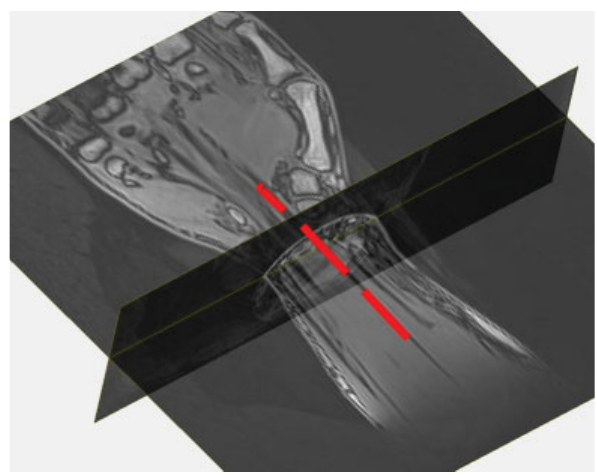
Fig. 5 Three-dimensional image illustrates automatic fi ber tracking of the median nerve.